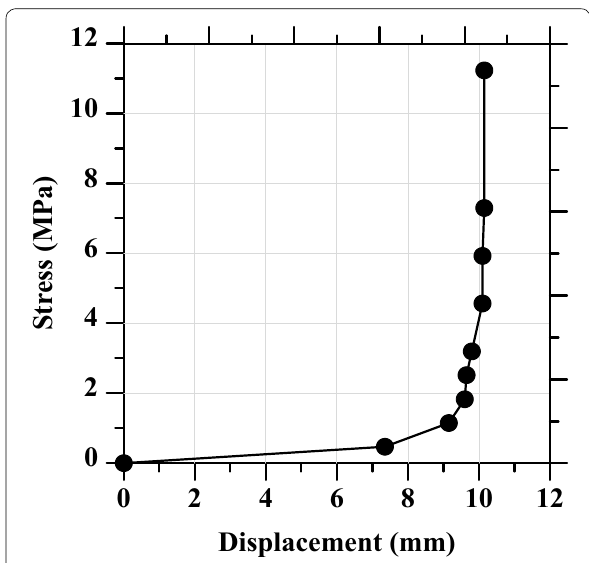
Fig. 7 Stress‑displacement diagram for the putty based composite rubber strip in the compression test.